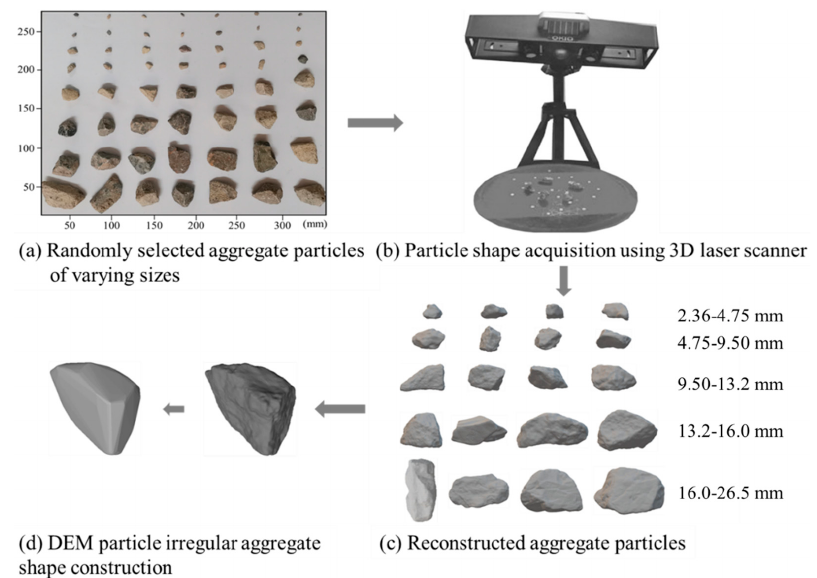
Figure 4. Illustration of the flowcharts of particle shape acquisition and quantification: ( a ) Randomly selected aggregate particles of varying sizes; ( b ) particle shape acquisition using 3D laser scanner; ( c ) Reconstructed aggregate particles; and ( d ) DEM particle irregular aggregate shape construction.